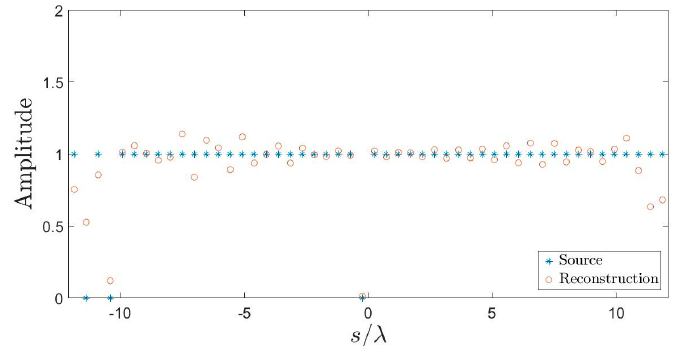
Figure 13. Reconstruction of a 50-element array with two faulty elements. The number of array elements is larger than the one estimated by (17) as the source NDF (45).